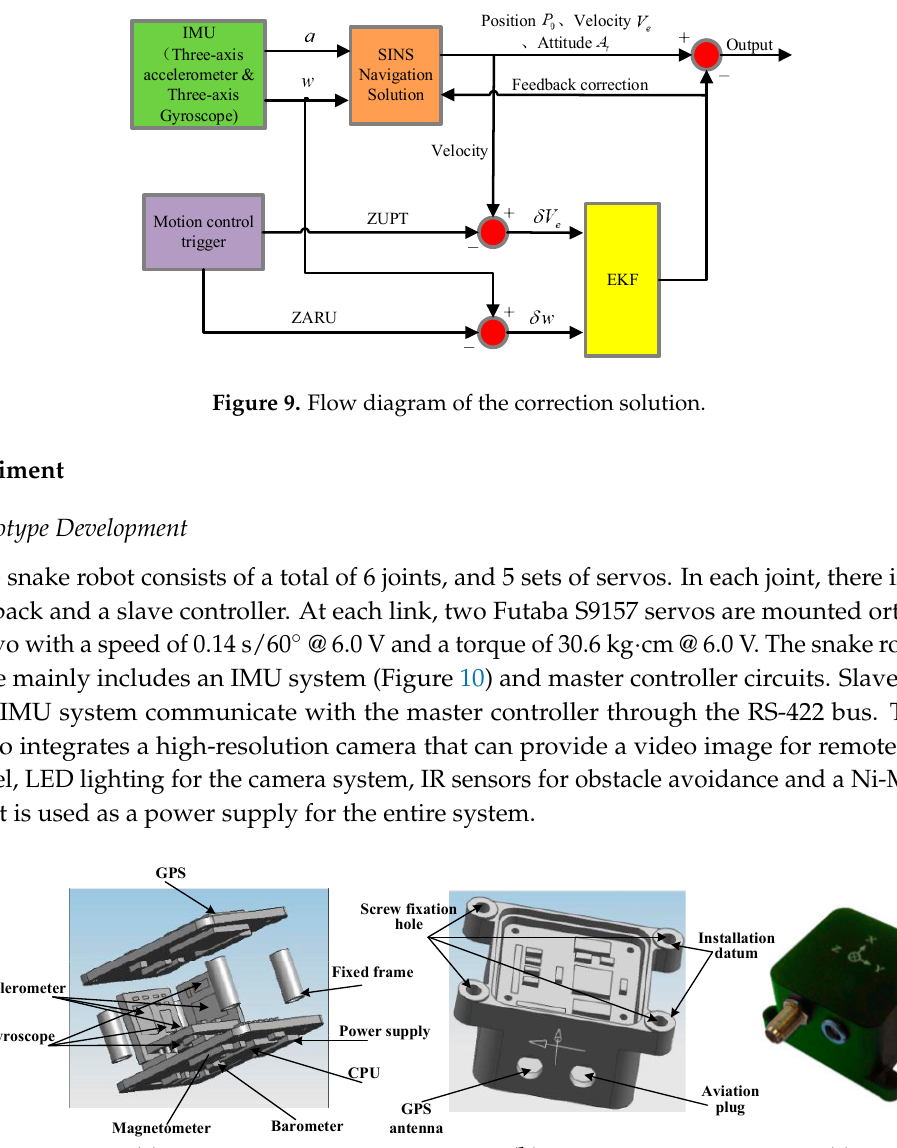
Figure 10. IMU and internal structure. ( a ) Exploded views of the IMU; ( b ) Assembly views of the IMU; ( c ) Overall views of the IMU.